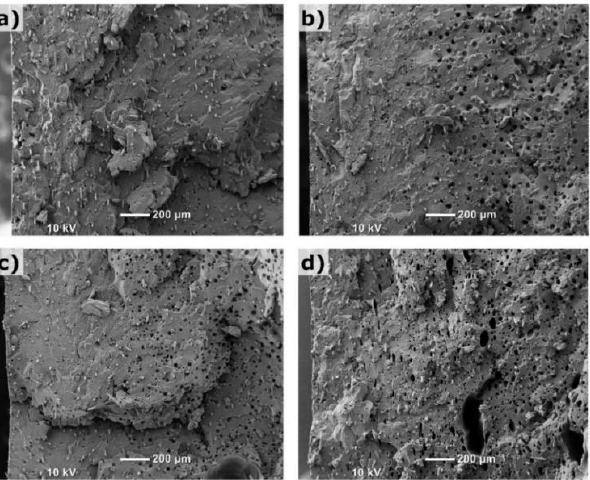
Figure 3. SEM images of cryogenically fractured tensile test bar samples at lower magnification: ( a ) solid; ( b ) MIM-1; ( c ) MIM-2; ( d ) MIM-3.